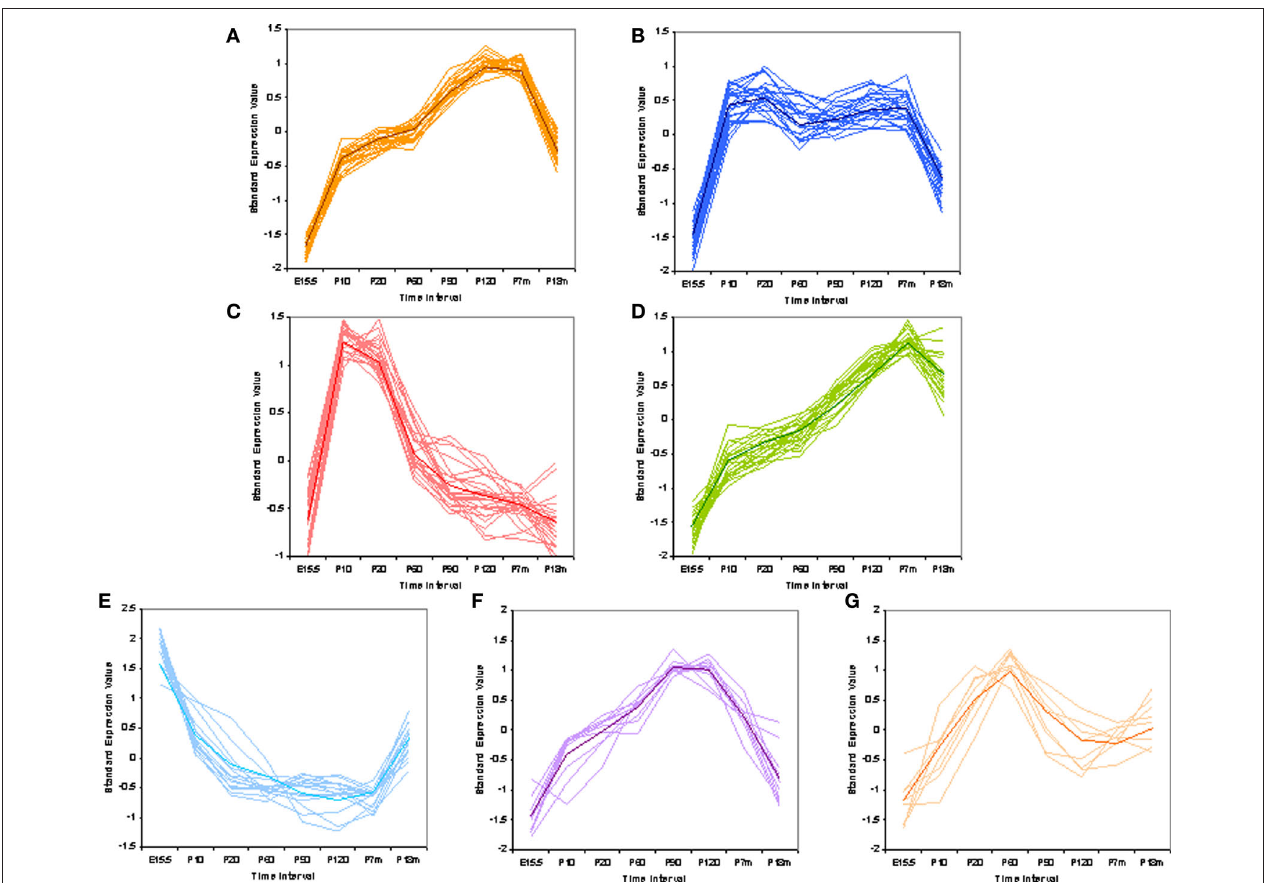
FiGuRe 5 | Pattern classification of mouse V1R and V2R genes. Standardized expression values were used to do pattern classification. Mean of the raw expression signal over all time points were standardized to zero. This is the composition of VR genes in each pattern: (A) 67 VRs, not biased to V1R or V2R; (B) 53 VRs, biased to V1Rs with hypogeometric p -value at 0.00033; (C) 36 VRs,